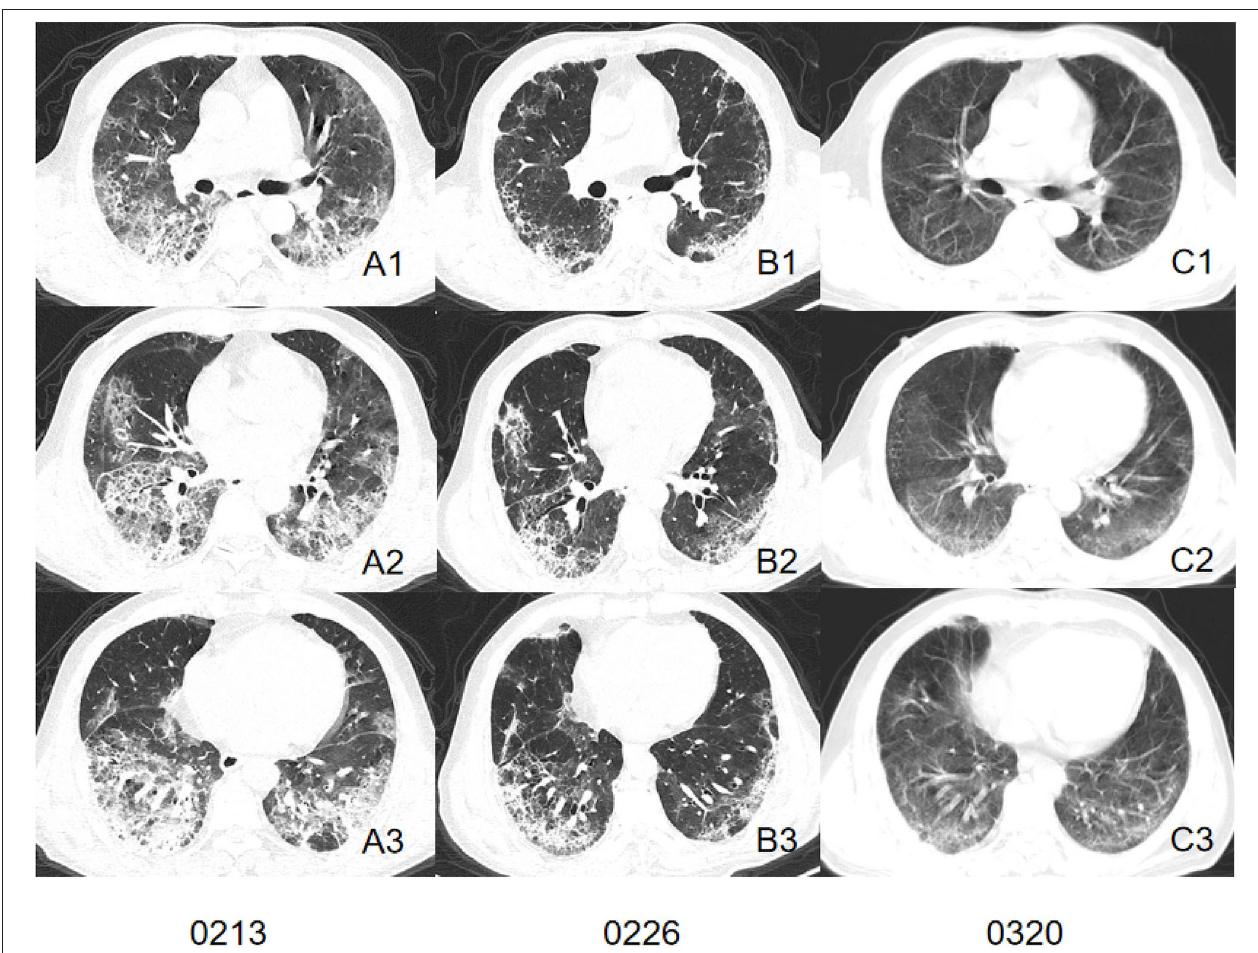
FIGURE 2 | CT images of a patient in smoking group. Initial CT imaging (A1–A3) obtained on Feb 13 showed multiple GGO, mixed GGO, and consolidation with bilateral, peripheral, and predominately lower lung involvement. Interlobular septal thickening and reticulation were visible. Follow-up CT when discharged (B1–B3) showed absorbed lesion. Interstitial changes remained visible. A follow-up CT conducted 23 days after discharged (C1–C3) showed remain residual lesion with subpleural bands involved peripheral area of both